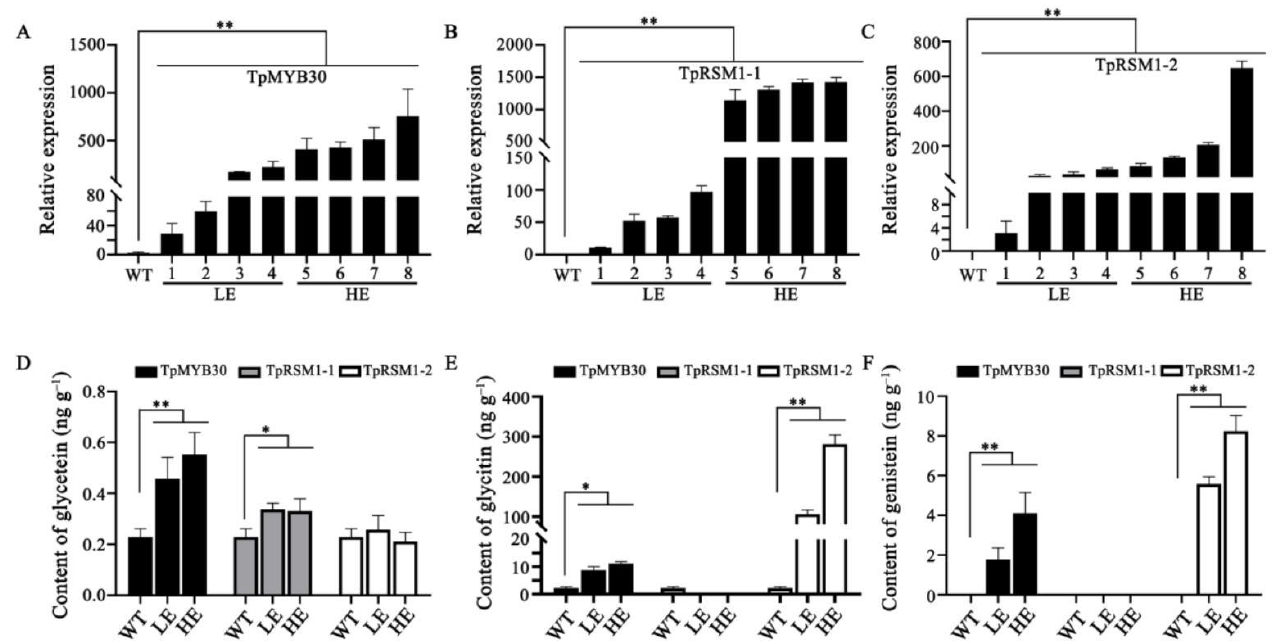
Figure 6. Effect of three MYB genes ( TpMYB30 , TpRSM1-1, and TpRSM1-2 ) on isoflavonoids biosynthesis. ( A ) The expression of TpMYB30 in wild-type and transgenic plants overexpressing TpMYB30 . ( B ) The expression of TpRSM1-1 in wild-type and transgenic plants overexpressing TpRSM1-1 . ( C ) The expression of TpRSM1-2 in wild-type and transgenic plants overexpressing TpRSM1-2 . ( D ) The content of glycetein in wild-type and transgenic plants overexpressing TpMYB30 , TpRSM1-1 , and TpRSM1-2 , respectively. ( E ) The content of glycitin in wild-type and transgenic plants overexpressing TpMYB30 , TpRSM1-1, and TpRSM1-2 , respectively. ( F ) The content of genistein in wild-type and transgenic plants overexpressing TpMYB30 , TpRSM1-1, and TpRSM1-2 , respectively. Bar data are the means of three biological replicates ± SD, and ANOVA analyses were conducted using one-way analysis of variance and Student’s t -test. Asterisks indicate significant difference (* p < 0.05, ** p < 0.01). The samples overexpressing TpMYB30 , TpRSM1-1, and TpRSM1-2 were divided into two groups: relatively low-expression (LE) and high-expression (HE) groups.